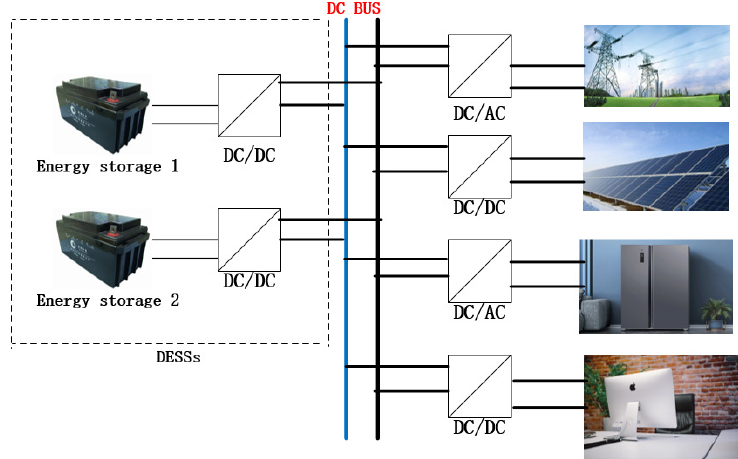
Figure 1. Typical DC microgrids with